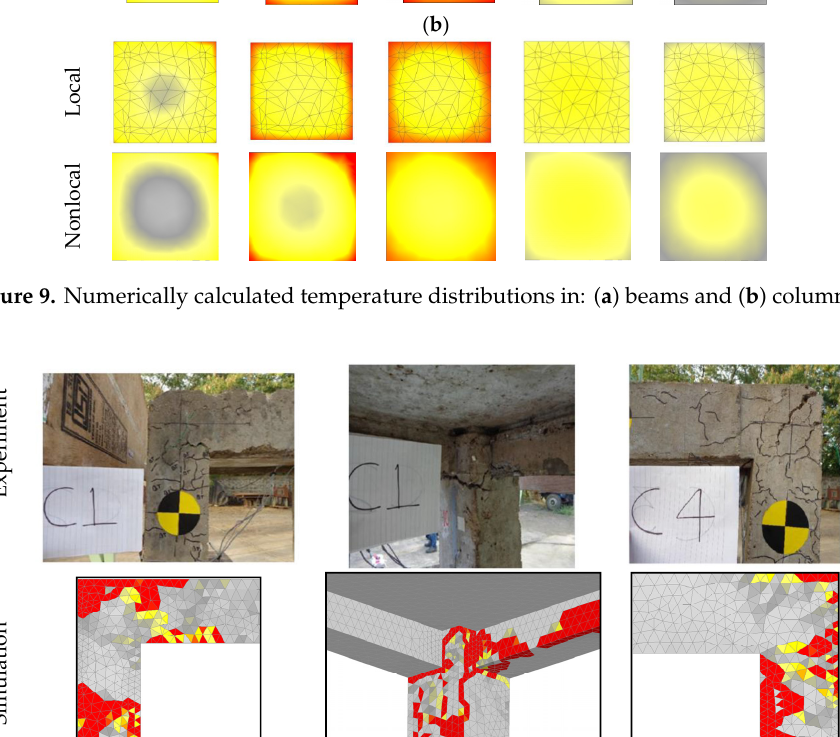
Figure 10. Damage of RC frame after thermal exposure and subsequent side impact of pendulum.